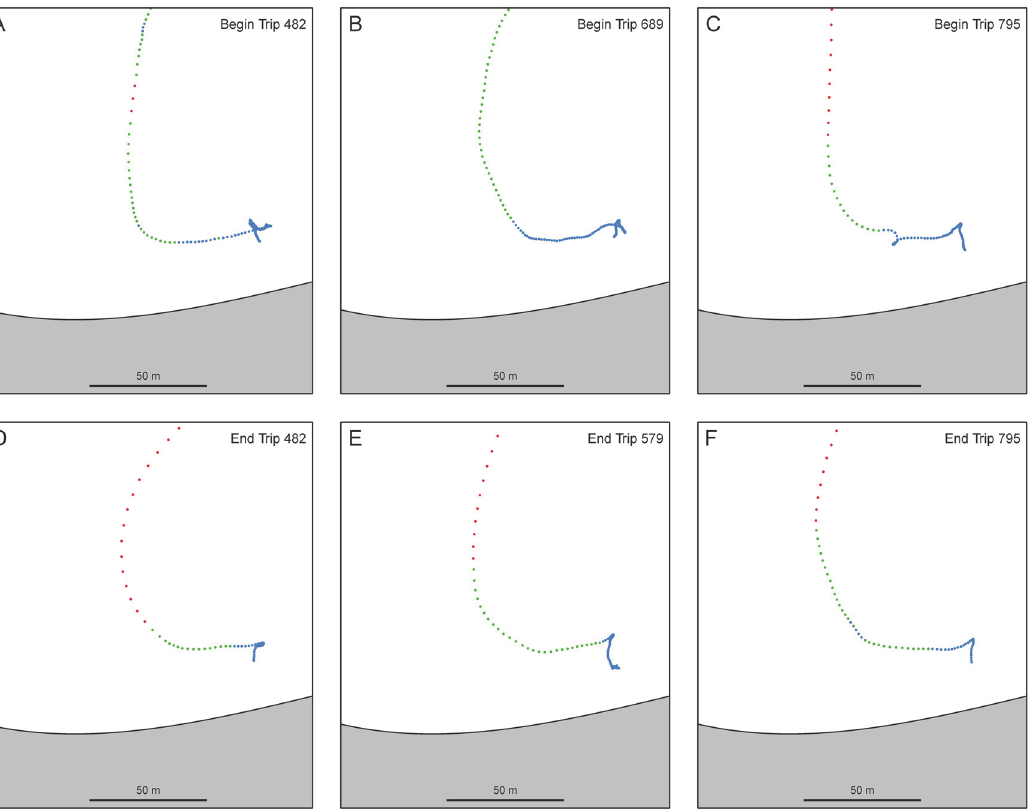
Fig 7. Travel segments in the harbor as trips were getting underway or coming to an end. These segments were misidentified as ARS in the MMA analysis and describe slow movement near the landing